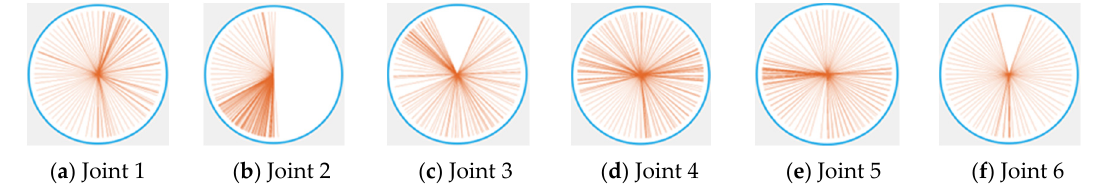
Figure 11. Angular distribution covering the joint space.